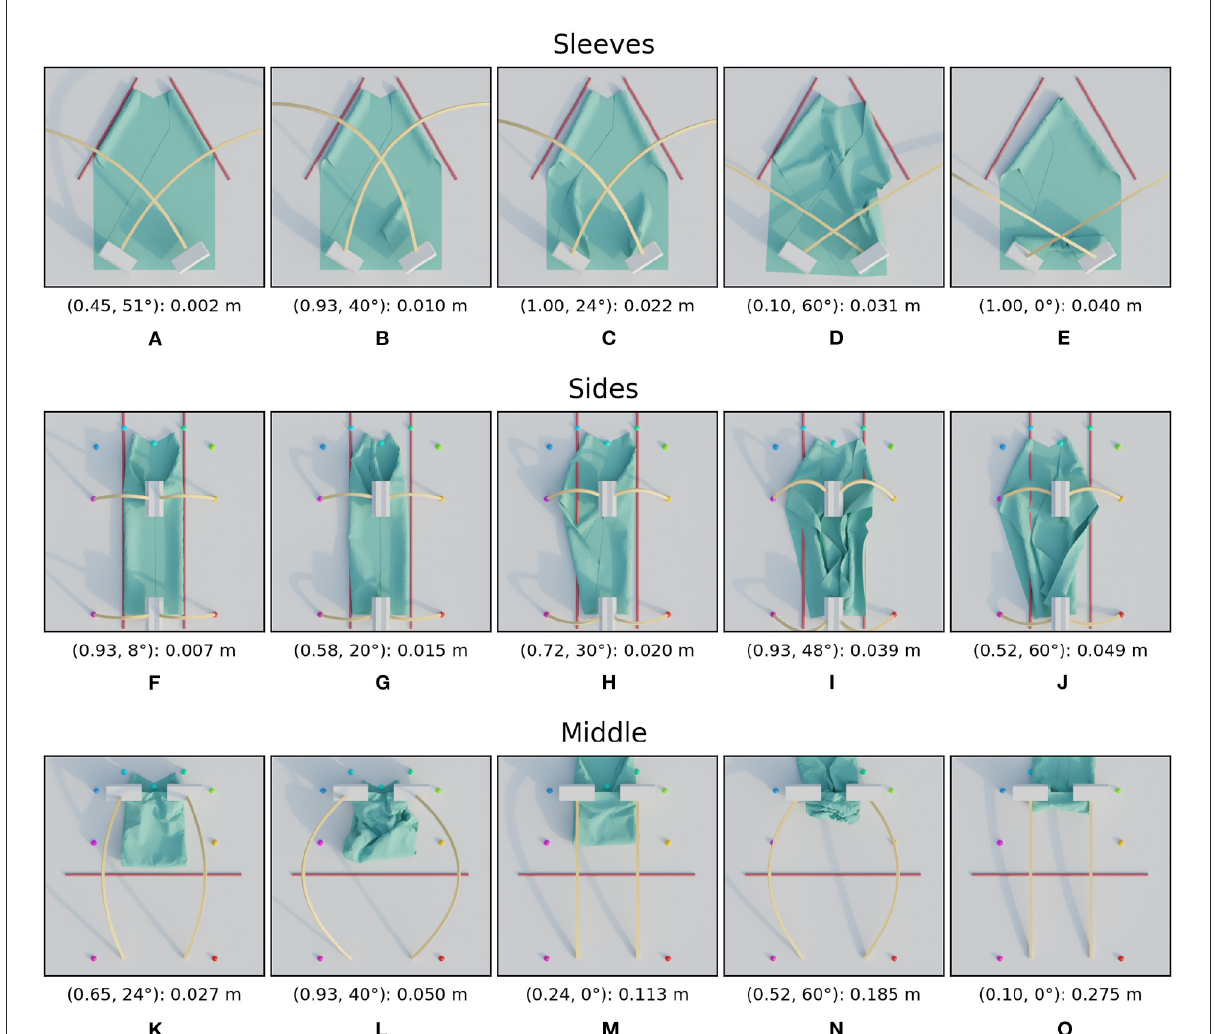
FIGURE14 Images of simulated results for the three phases of the folding sequence. For each row, the images are ordered from best (left) to worst (right) result. The annotation below each image is in the following format: (height ratio, tilt angle): mean distance. The first row (A–E) shows the images for the sleeves, the second row (F–J) for the sides, and the third (K–O) for the middle. Note that the side folding stage starts from the cloth as seen in (A) , the best result from the sleeve folding. The middle folding similarly starts from (F) , the best result from the side folding.